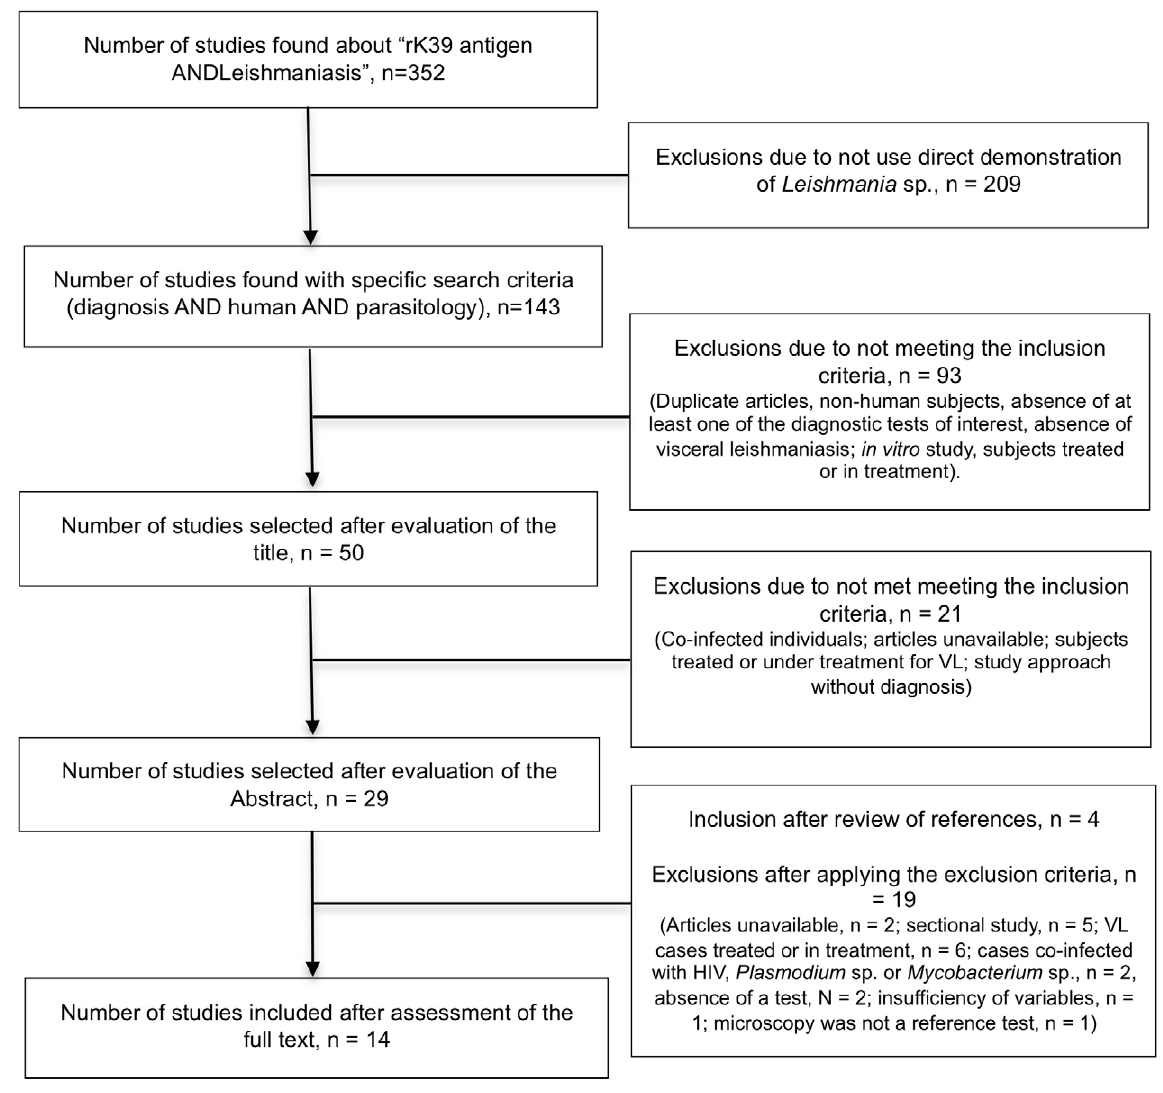
Figure 1. Algorithm for selection of studies.